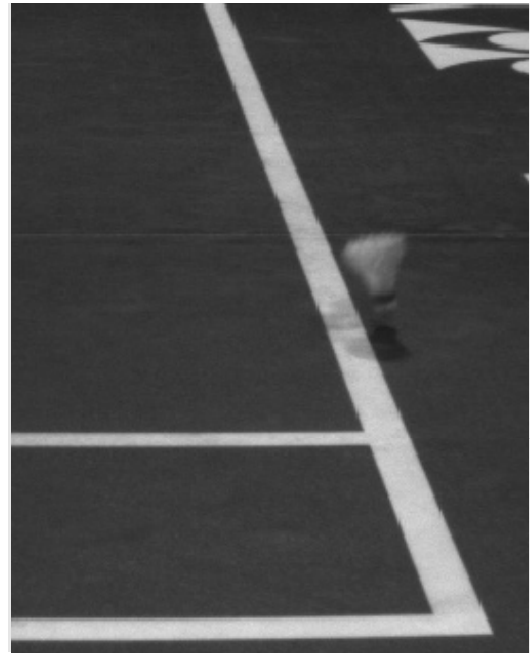
Figure 15. After the ground hit.